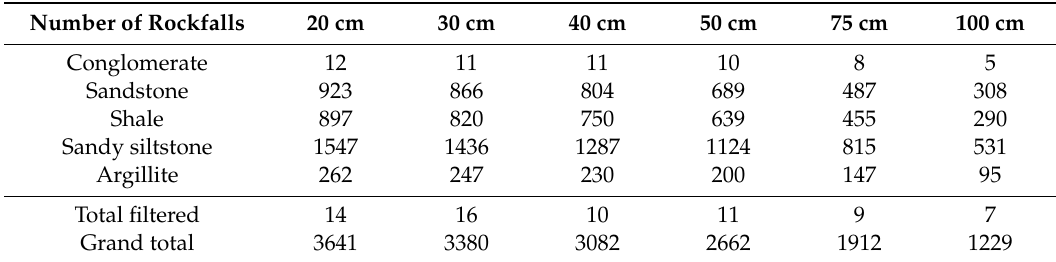
Table 1. The number of rockfalls extracted and filtered for each inventory with di ff ering M3C2 projection diameters.